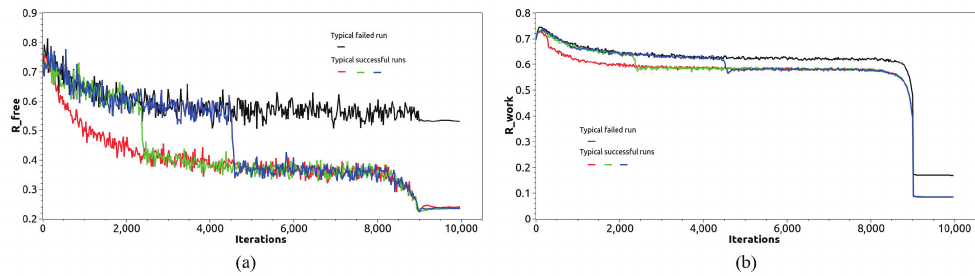
Figure 3. The evolution of ( a ) R free , ( b ) R work for the ab initio phasing of 6c4y. The initial phases are random. When a solution is achieved, R values indicates a sudden drop. After the 9000th iteration, solvent flattening is applied.